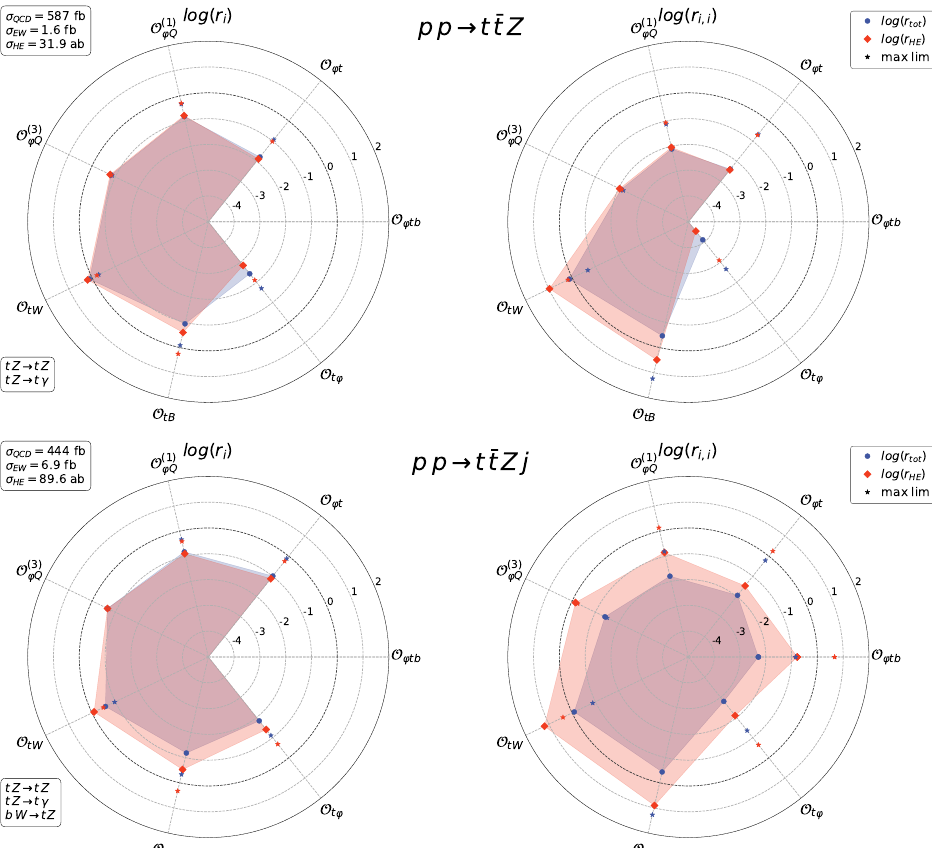
Figure 25. Radar plot for the p p LHC, see (cid:12)gure 7 and section 4.1.2 of the main text for a detailed description. The b (cid:22) b -initiated component has not been